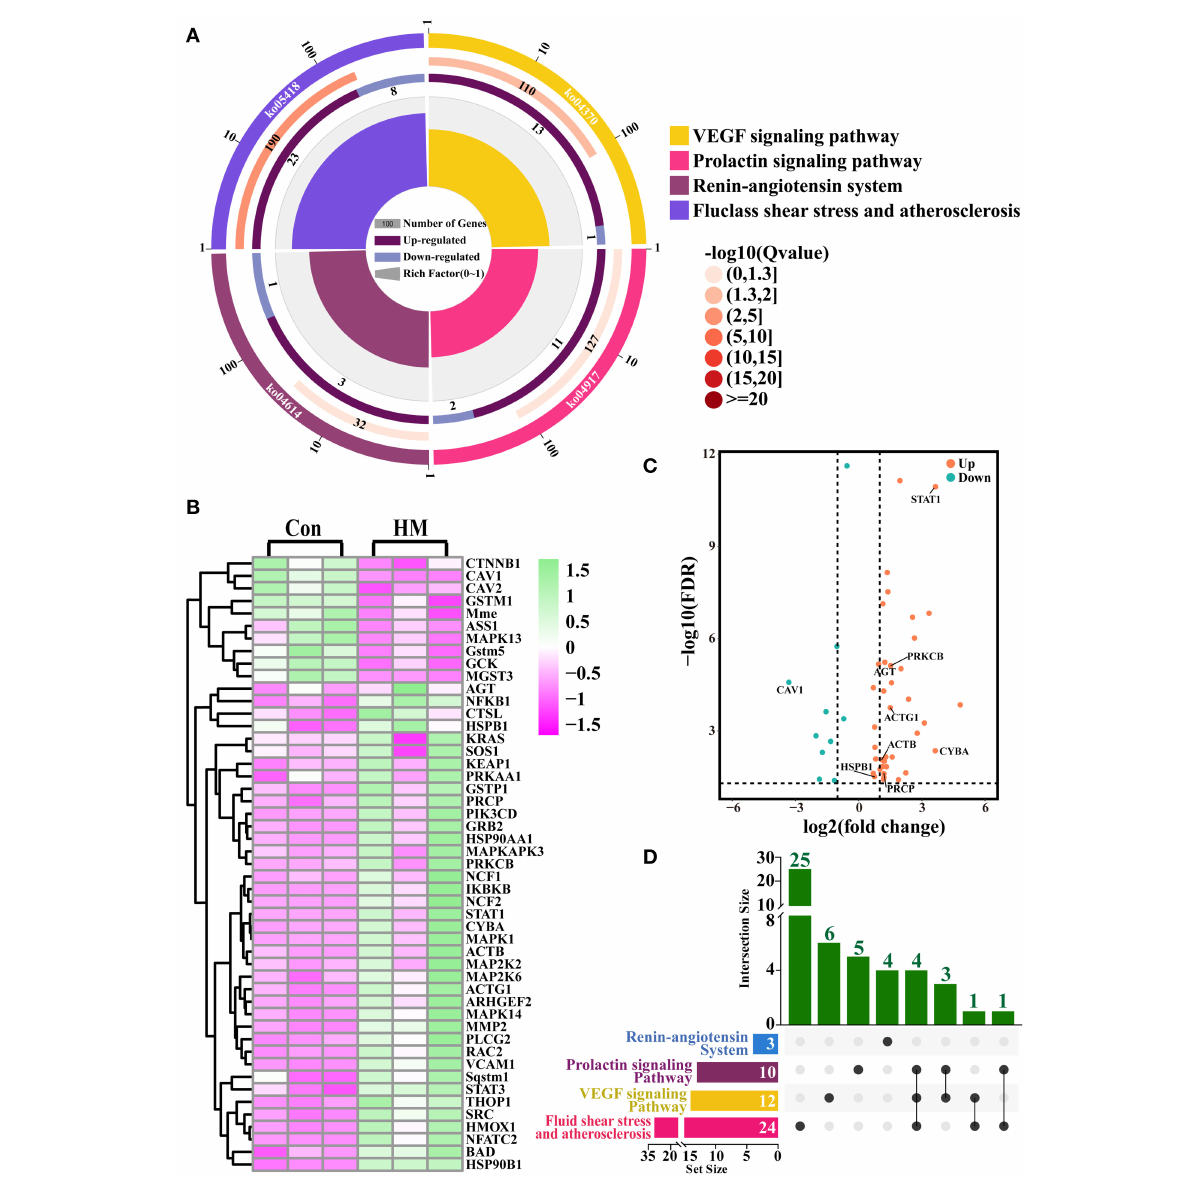
FIGURE5 The candidate DEPs and pathways related to blood, vascular or vasculature, and angiogenesis. (A) the candidate pathways related to blood, vascular or vasculature, and angiogenesis selected from the 68 significantly different pathways according to KEGG annotation of the 3,739 DEPs. (B) heat-map of the 49 DEPs selected from the four significantly different pathways. (C) Volcano plots of the 49 DEPs including 10 down-regulated and 39 up-regulated proteins. (D) Upset Venn diagram of the 49 DEPs and the four pathways. Con, control group; HM, hemorrhagic mastitis